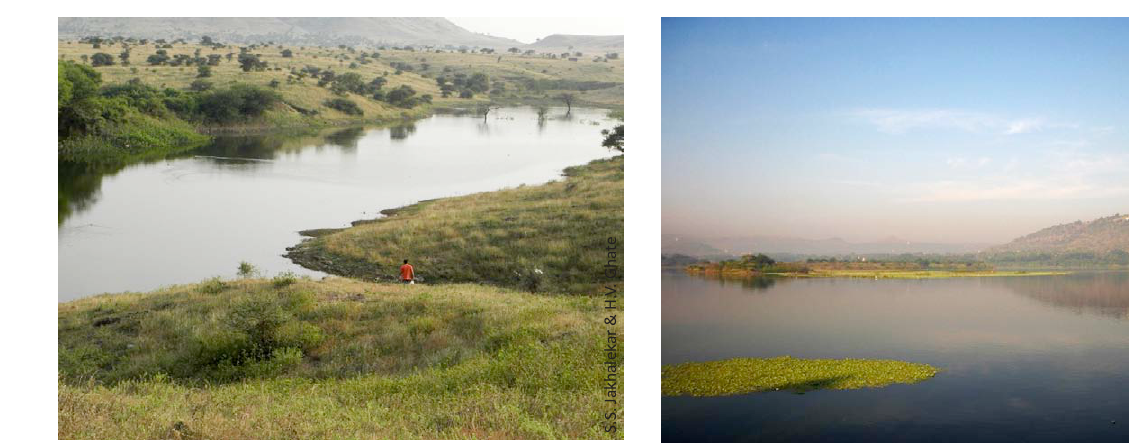
Image 2. Manmade permanent water reservoir at Pashan, Pune.